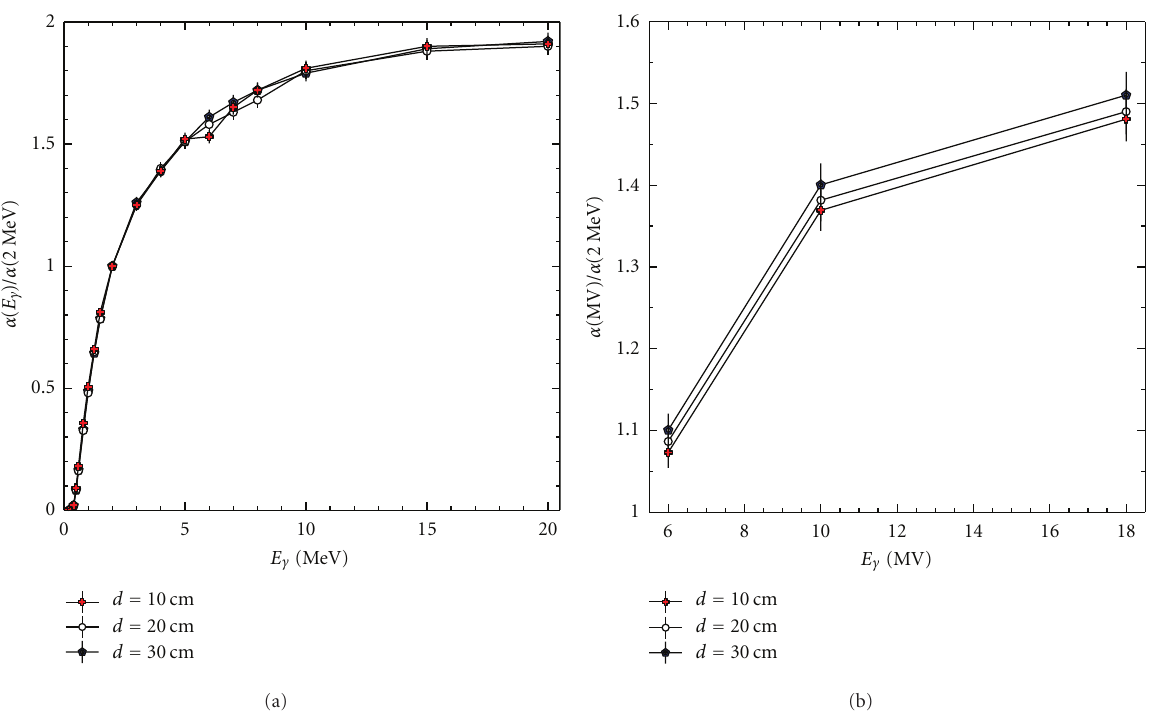
Figure 14: Energy dependence curves for the CPID without water phantom. The α ( E γ ) /α (2MeV) curve for monoenergetic beams is shown on the left and α (MV) / α (2MeV) curve for polyenergetic beams is shown on the